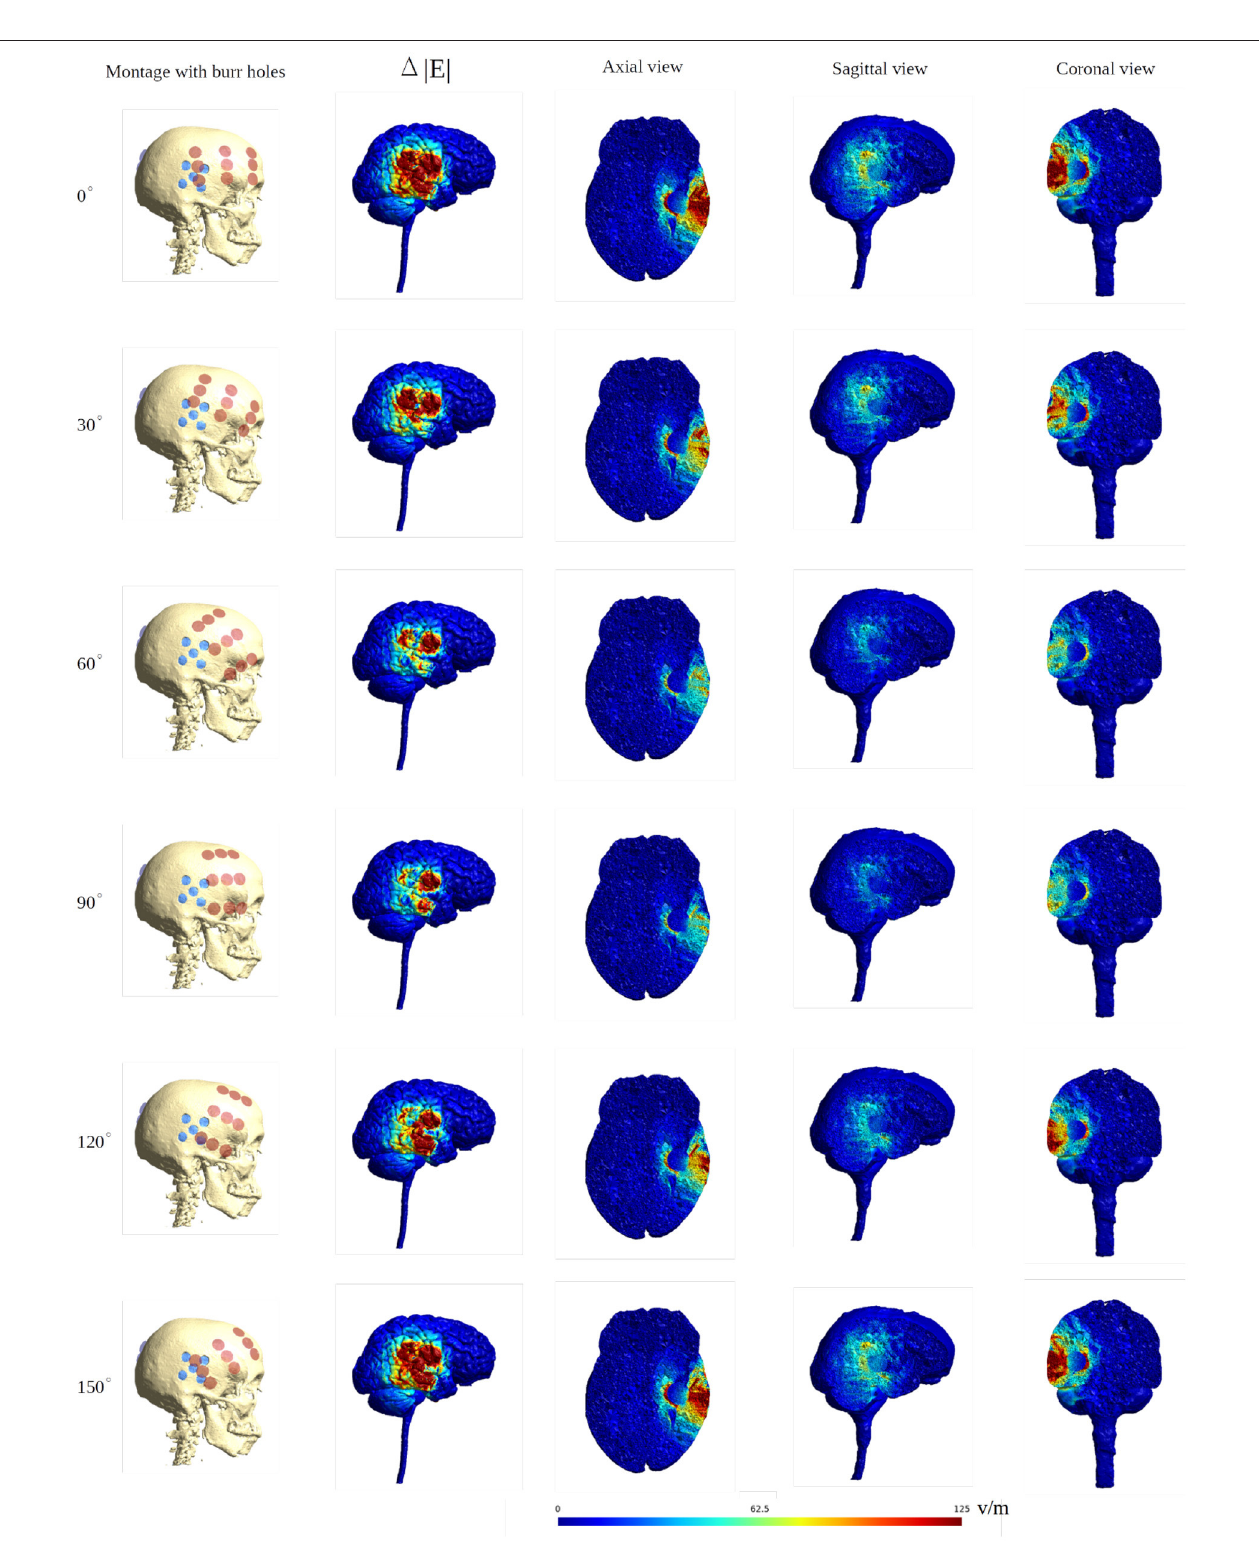
FIGURE 10 | Heat map of the electric field intensity enhancement of the SR surgery, with the rotation of the ipsilateral array around the axis normal to the skin surface at the center of the array. The contralateral array is kept in the opposing position without rotation. The red and blue dots in the first column represent the placements of the electrodes and the burr holes. The second column gives the enhancement on the gray matter surface, and the last three columns show different views of the field enhancement.